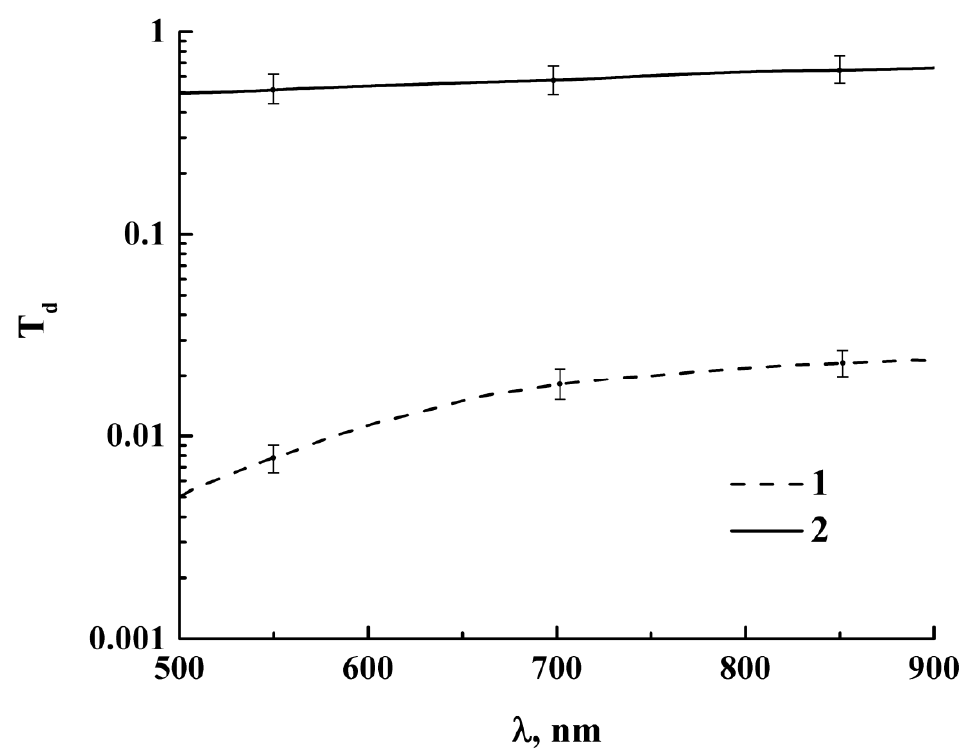
Figure 3. The di ff use transmittance spectra of the examined samples in the wet state. 1—TiO 2 -based Figure 3. The diffuse transmittance spectra of the examined samples in the wet state. 1—TiO 2 ‐ based system; 2—SiO 2 -based system. Selectively shown error bars correspond to a confidence level of system; 2—SiO 2 ‐ based system. Selectively shown error bars correspond to a confidence level of 0.9.